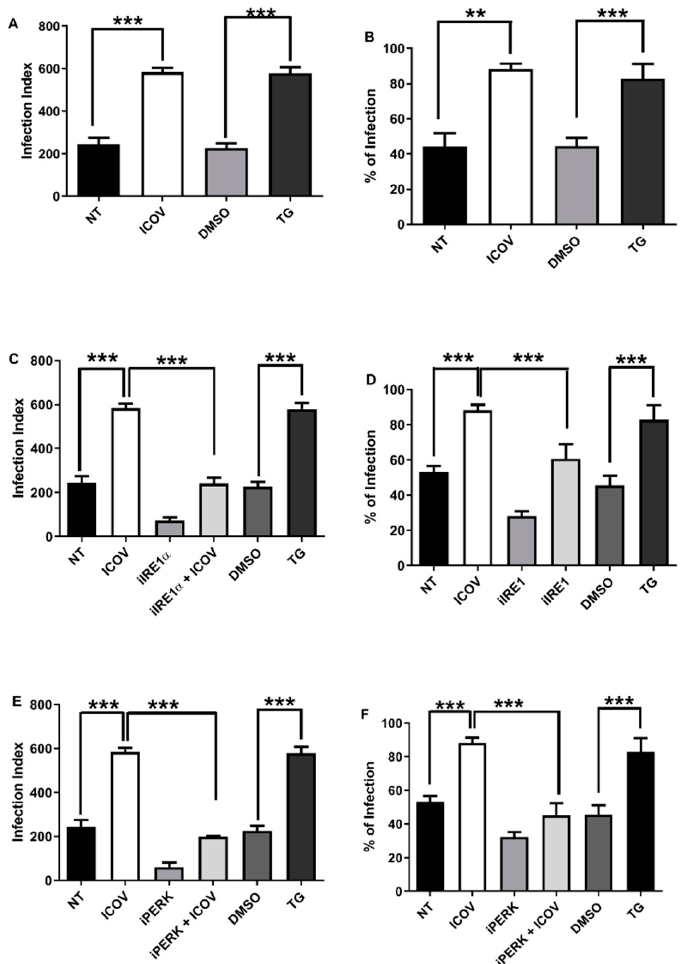
Figure 2. The replication of L. amazonensis is favored during ICOV coinfection in an ER stress pathway dependent manner. Peritoneal macrophages from C57BL/6 mice were not treated (NT), infected with Phlebovirus Icoaraci (ICOV) at MOI 1, treated with 1 µ M Tapsigargin (TG) for 1 h ( A , B ) or DMSO and pre-treated with 100 nM of IRE1a inhibitor during 1 h ( C , D ) or with 40 nM of PERK inhibitor during 1 h ( E , F ) followed by ICOV infection. After, all cells were infected with stationary-phase promastigotes of L. amazonensis at a ratio of 5 parasites/cell. At 48 h pi, one hundred Giemsa-stained cells were inspected, and the infection index was calculated (percentage of infected macrophages multiplied by the average number of amastigotes per macrophage) and the percentages of infected macrophages as indicated in the figure. Asterisks indicate significant differences between groups by ANOVA, with ** p < 0.001 or *** p < 0.0001.